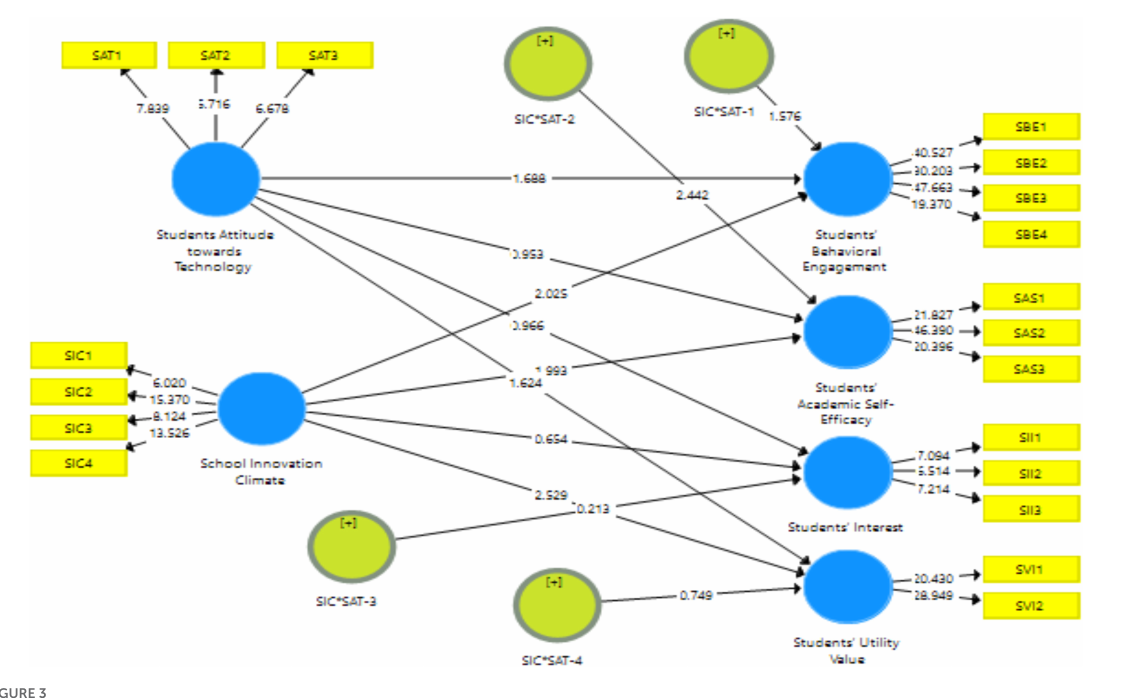
FIGURE3 Structural model assessment.